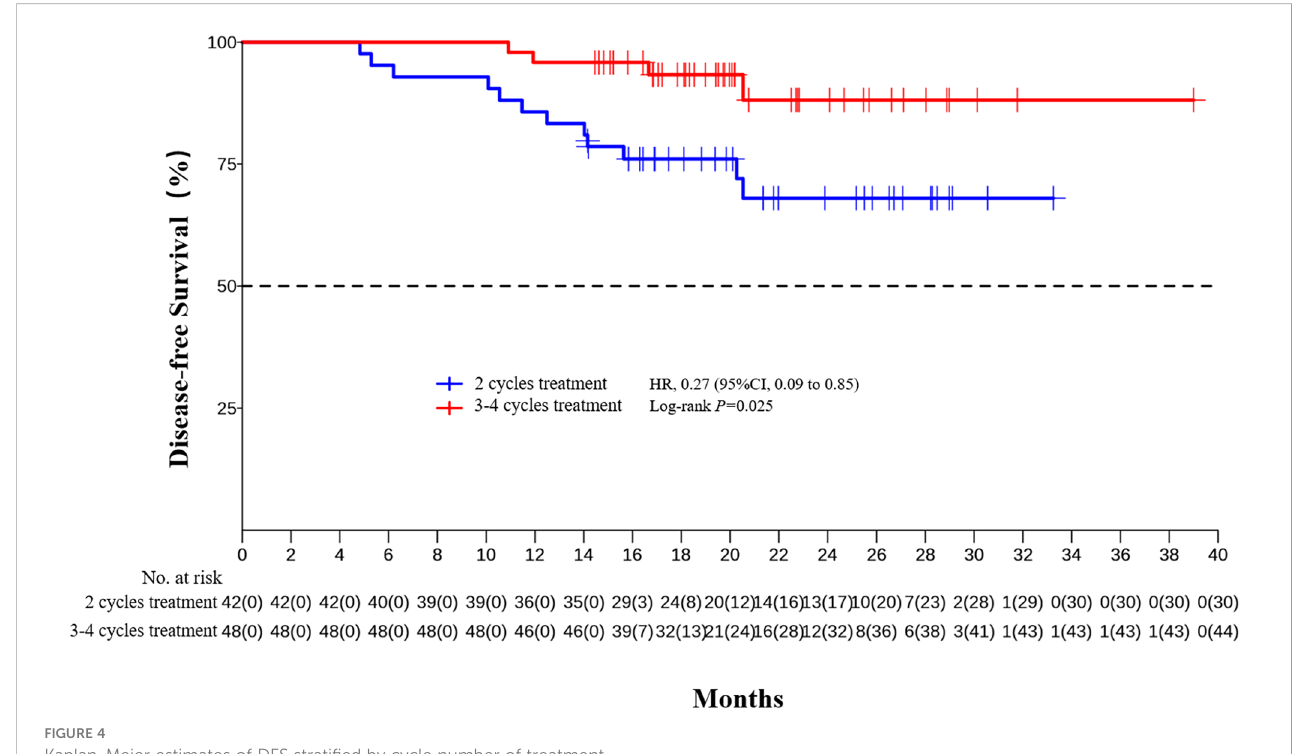
FIGURE 4 Kaplan-Meier estimates of DFS strati fi ed by cycle number of